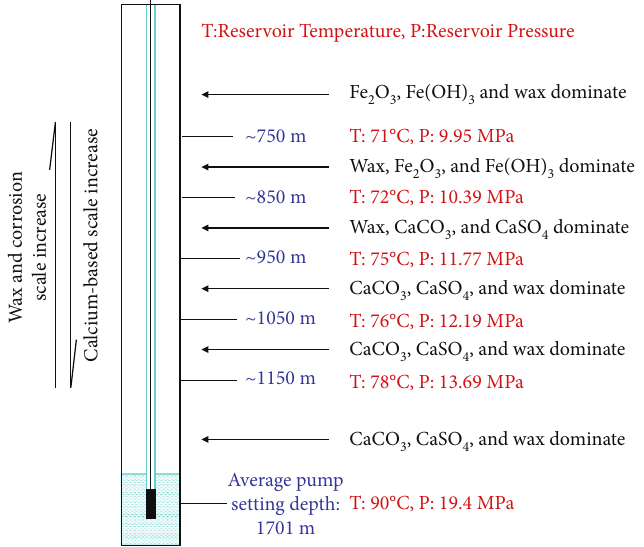
Figure 8: Wellbore scaling characteristics for Chang 8